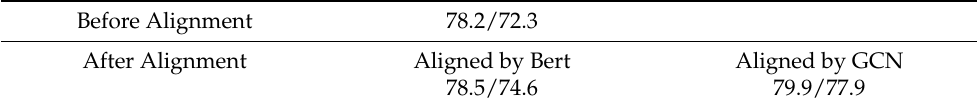
Table 5. MiF 1/ MaF 1 by LSTM on MS-COCO (before and after alignment).